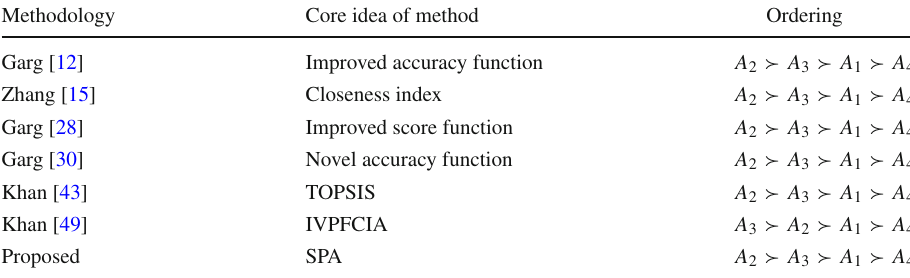
Table 2 Comparative analysis for examples in “Illustrative